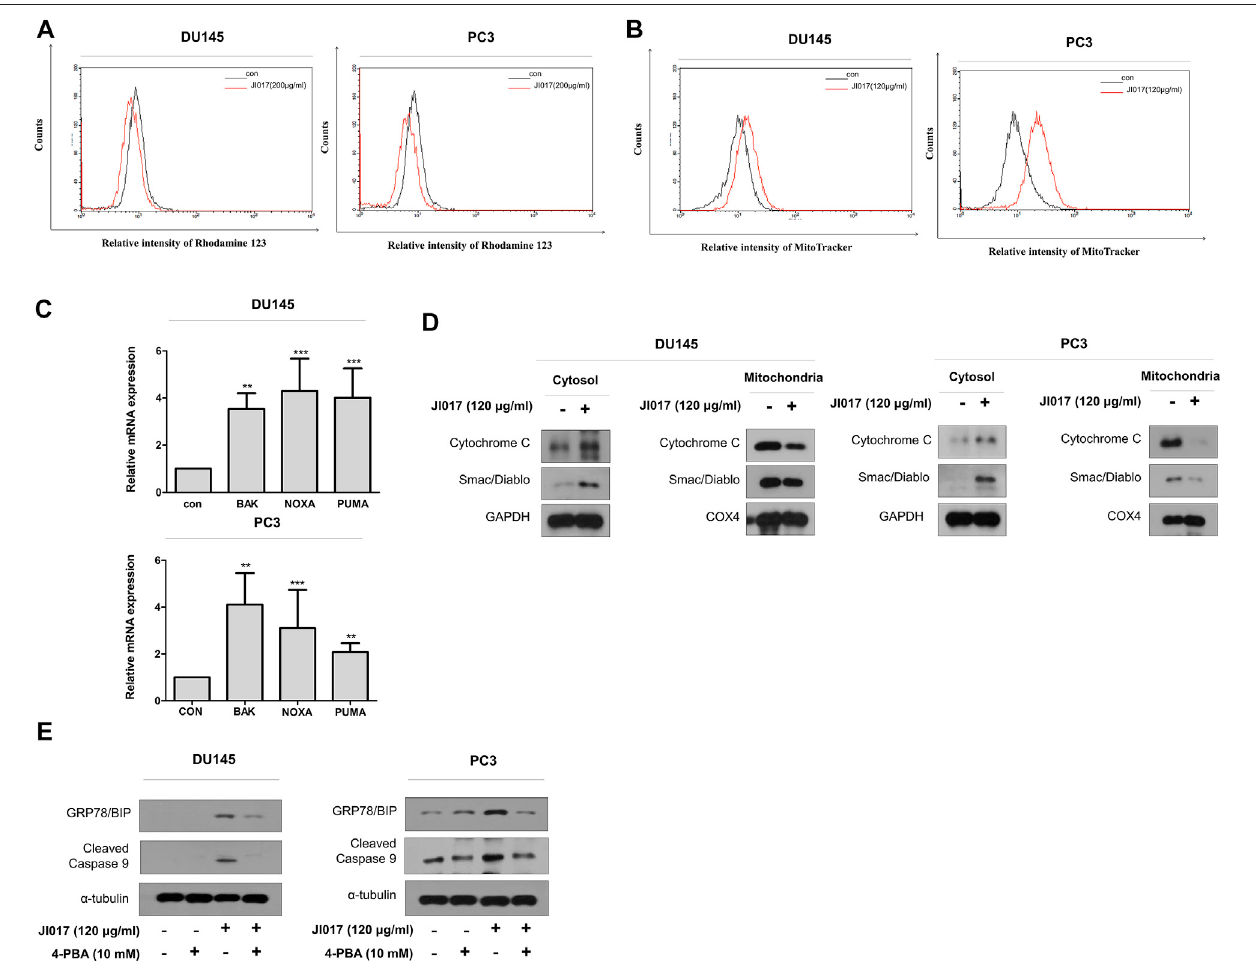
FIGURE 6 | Induction of the mitochondrial dysfunction response by UPR signaling. DU145 and PC3 cells were treated with JI017 for 24 h and subjected to the rhodamine 123 assay (A) . DU145 and PC3 cells were treated with JI017 for 24 h and stained with MitoTracker (300 nM) (B) . The expression of BAK, NOXA, and PUMA mRNAs was measured by RT-qPCR (C) . Mitochondrial, and cytosolic extracts of cultured cells were prepared and analyzed by western blotting to detect the levels of cytochromecandSmac/Diablo (D) .EffectofanERstressinhibitor(4-PBA)onJI017-inducedmitochondrialapoptosispathway.Pretreatmentwith4-PBA(10 mM) for 1 hwasfollowed byJI017 treatment. Wholecell lysateswereanalyzed bywesternblottingwithanti-CHOP, anti-cleavedcaspase-9, andanti-GAPDH antibodies (E) . The data are presented as the mean ± SEM. * p < 0.05, ** p < 0.01, and *** p < 0.001 compared to untreated cells.